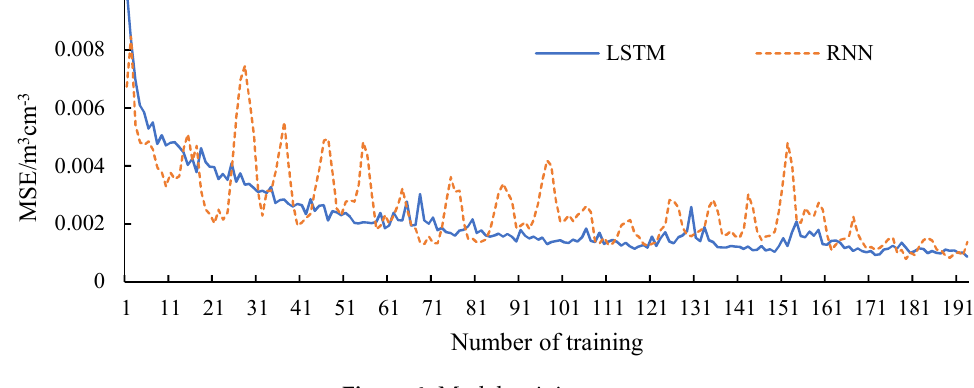
Figure 6. Model training error.